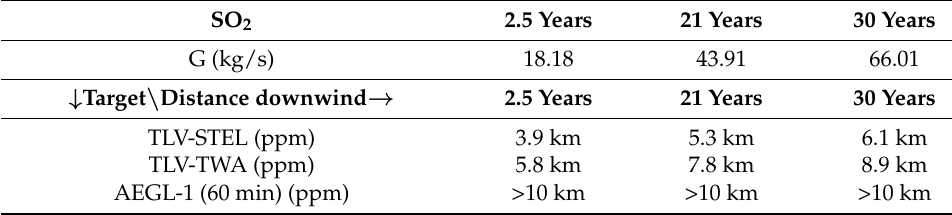
Table 9. SO 2 dispersion calculations using the Britter–McQuaid